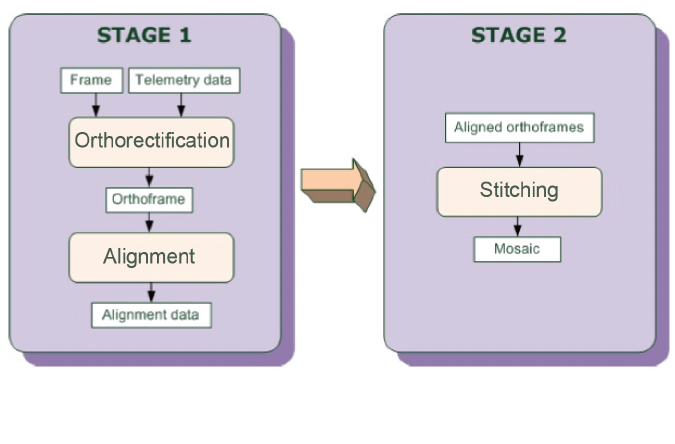
Figure 3. Overview of the Algorithm for